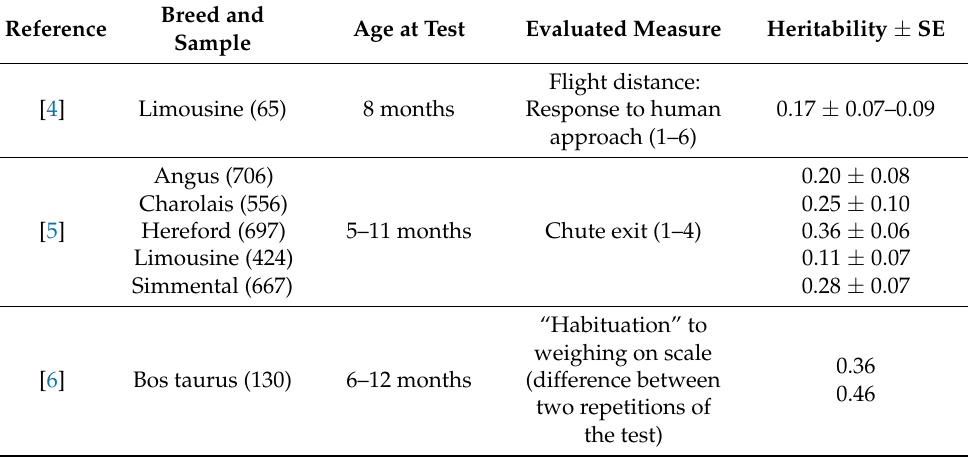
Table 1. Heritability estimates for some behavioral tests in different beef cattle